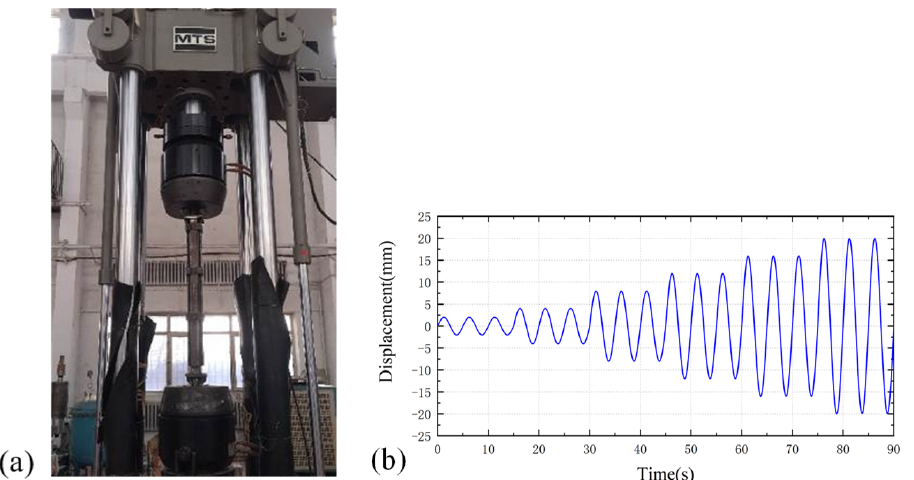
Figure 3. Loading instrument and loading protocol: ( a ) loading instrument; and ( b ) loading protocols.